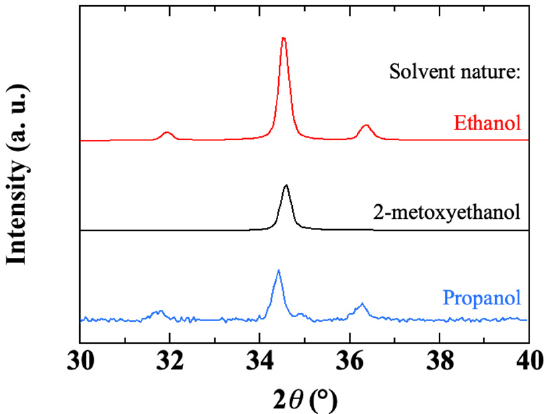
Figure 17. X-ray diffractograms of sol-gel spin-coated ZnO thin films deposited with different solvents.